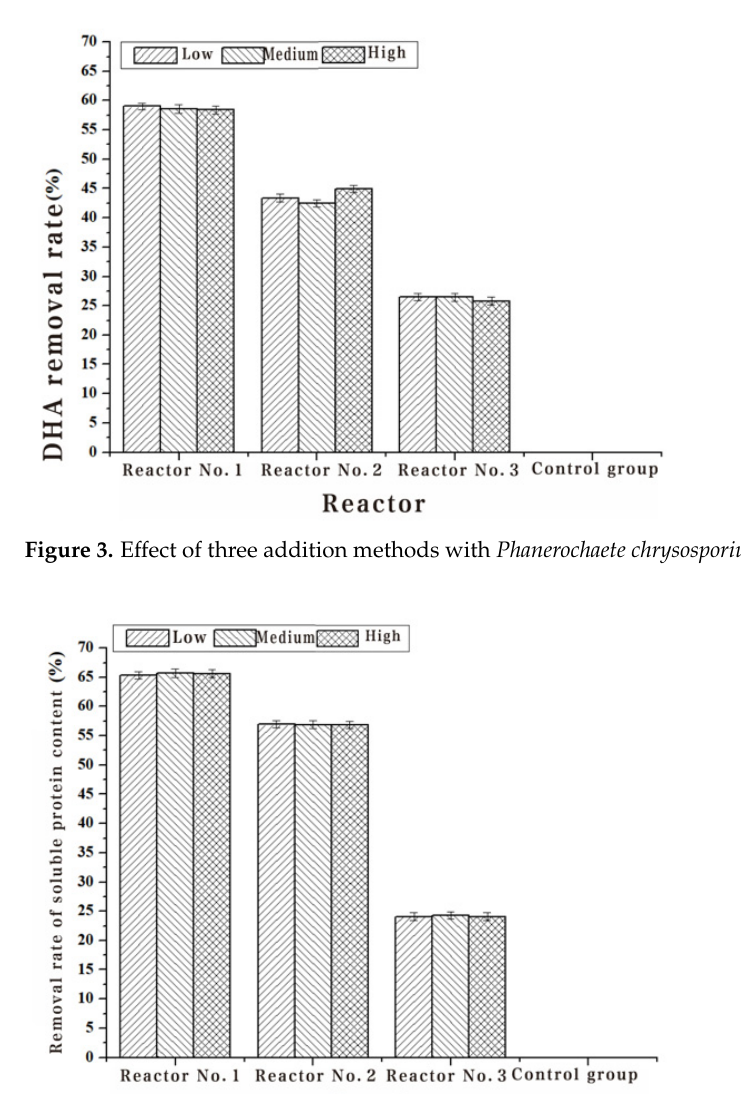
Water 2022 , 14 , x FOR PEER REVIEW